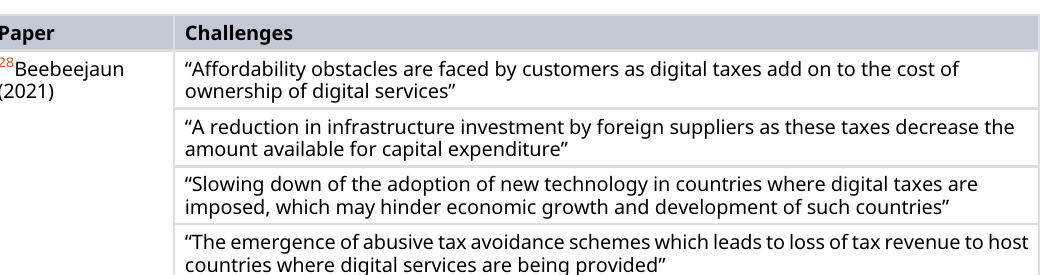
Table 5. Challenges of digital taxation.